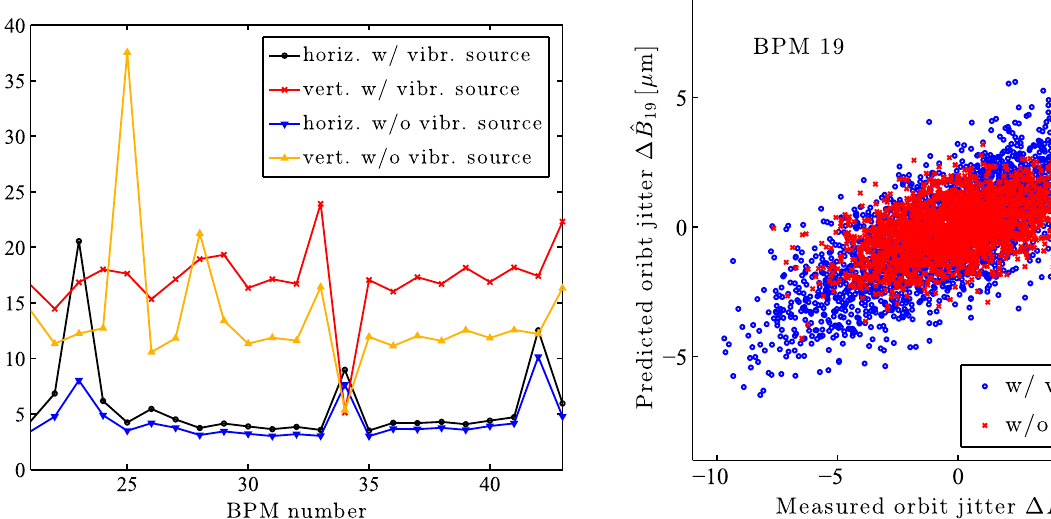
FIG. 14. RMS orbit jitter relative to the beam size before and after the removal of the vibration sources.